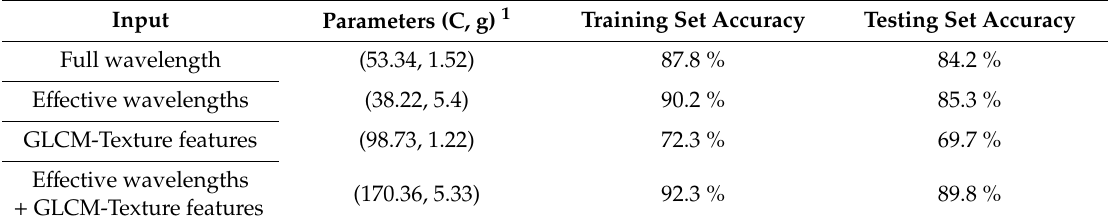
Table 5. Hyperspectral imaging for soil type classification with SPA and